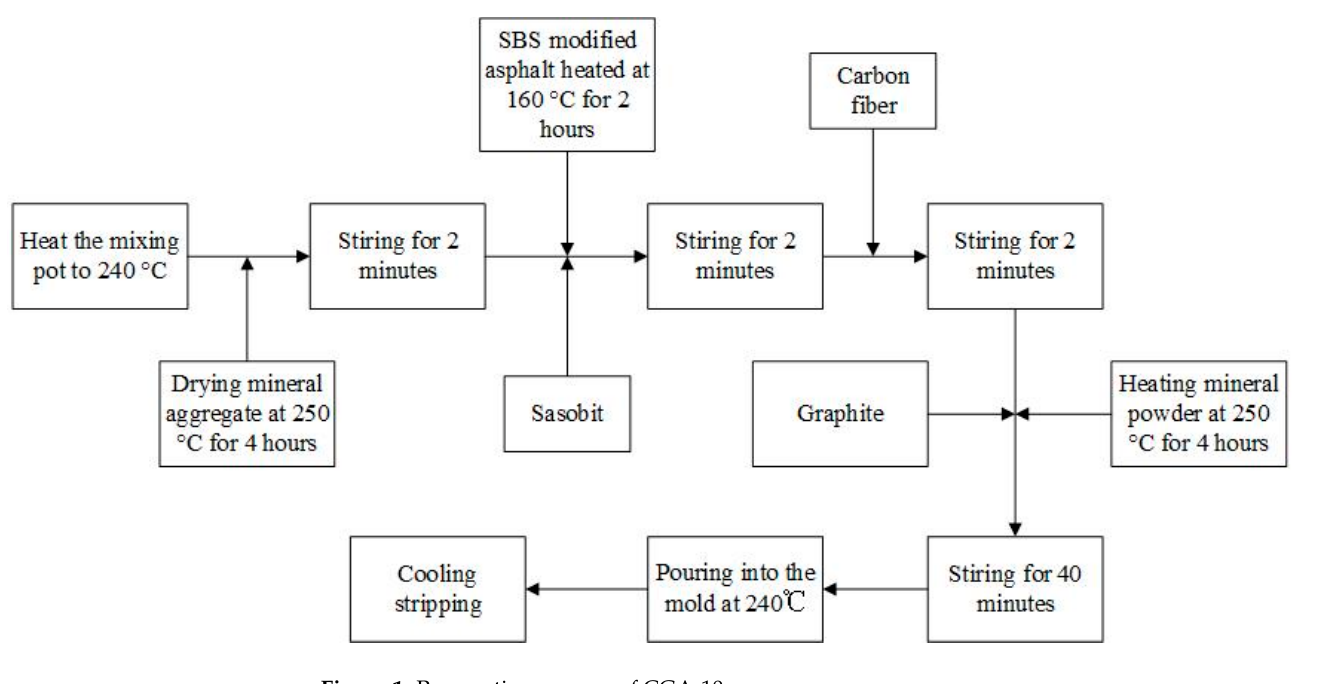
Figure 1. Preparation process of CGA-10.